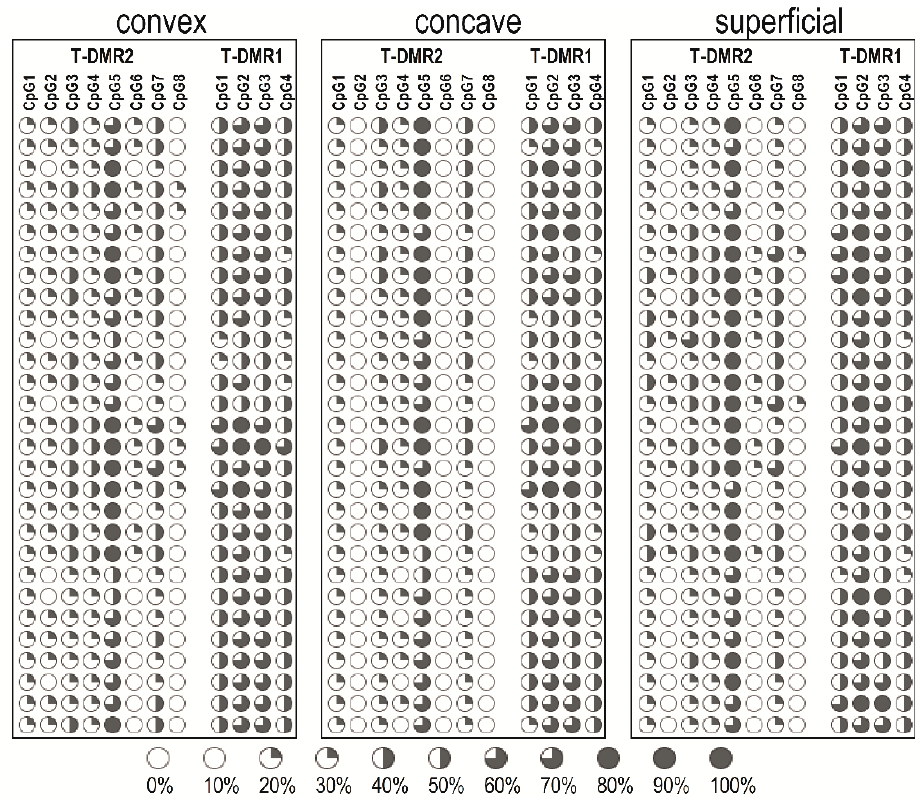
Figure 2. Dot plot of ESR1 T-DMR1 and T-DMR2 regions methylation pattern of individual patients.